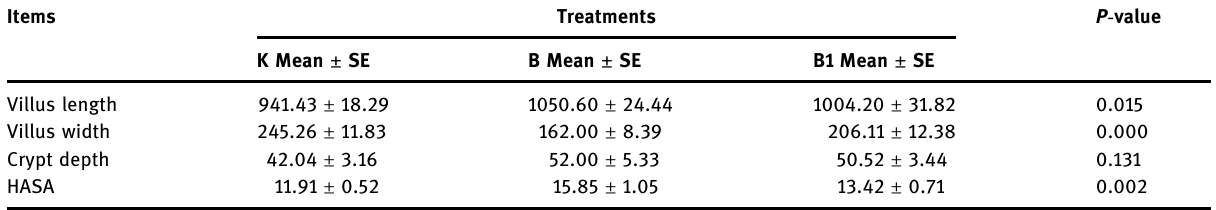
Table 4: E ff ect of sodium borate injected in ovo on the intestinal morphology ( jejunum ) of chickens at 14 days of age